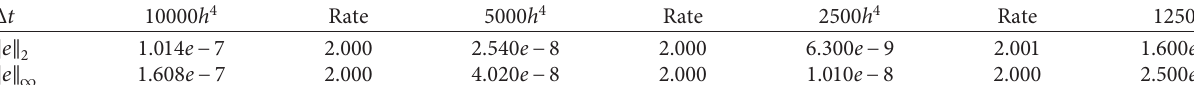
Table 4: Errors and convergence rates for the numerical results of the CN scheme at the final time T � 10 7 h 4 . Here, h � 1/128 is used.